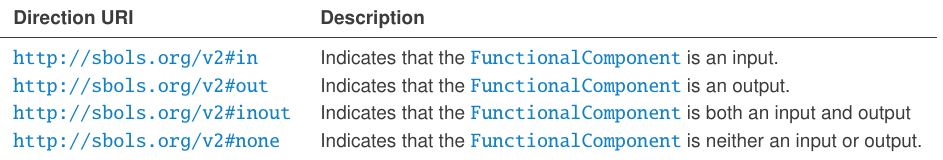
Table 12: REQUIRED URI s for the direction